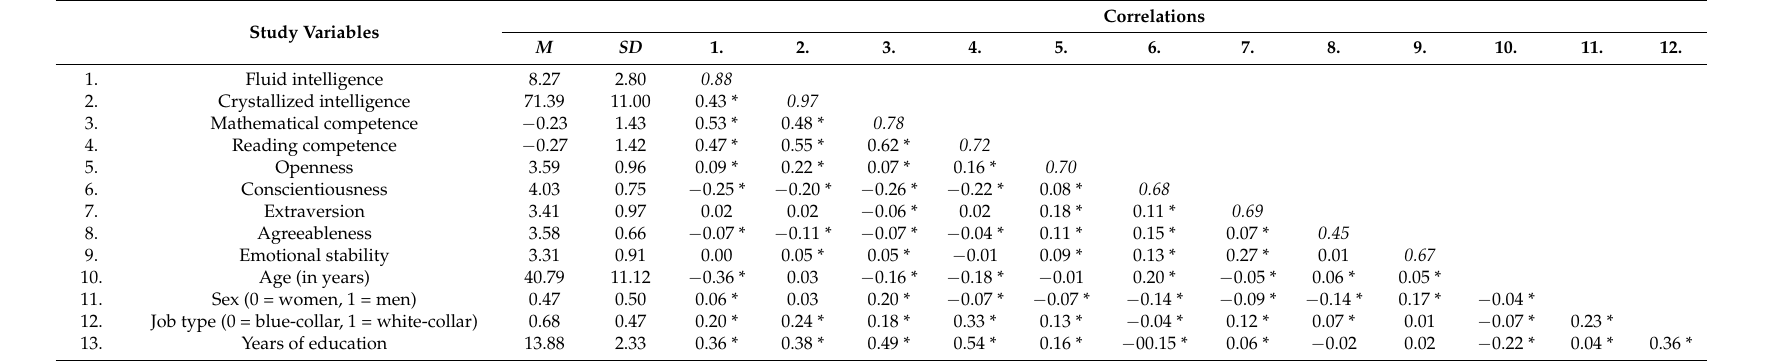
Table 1. Means, standard deviations, and correlations between study